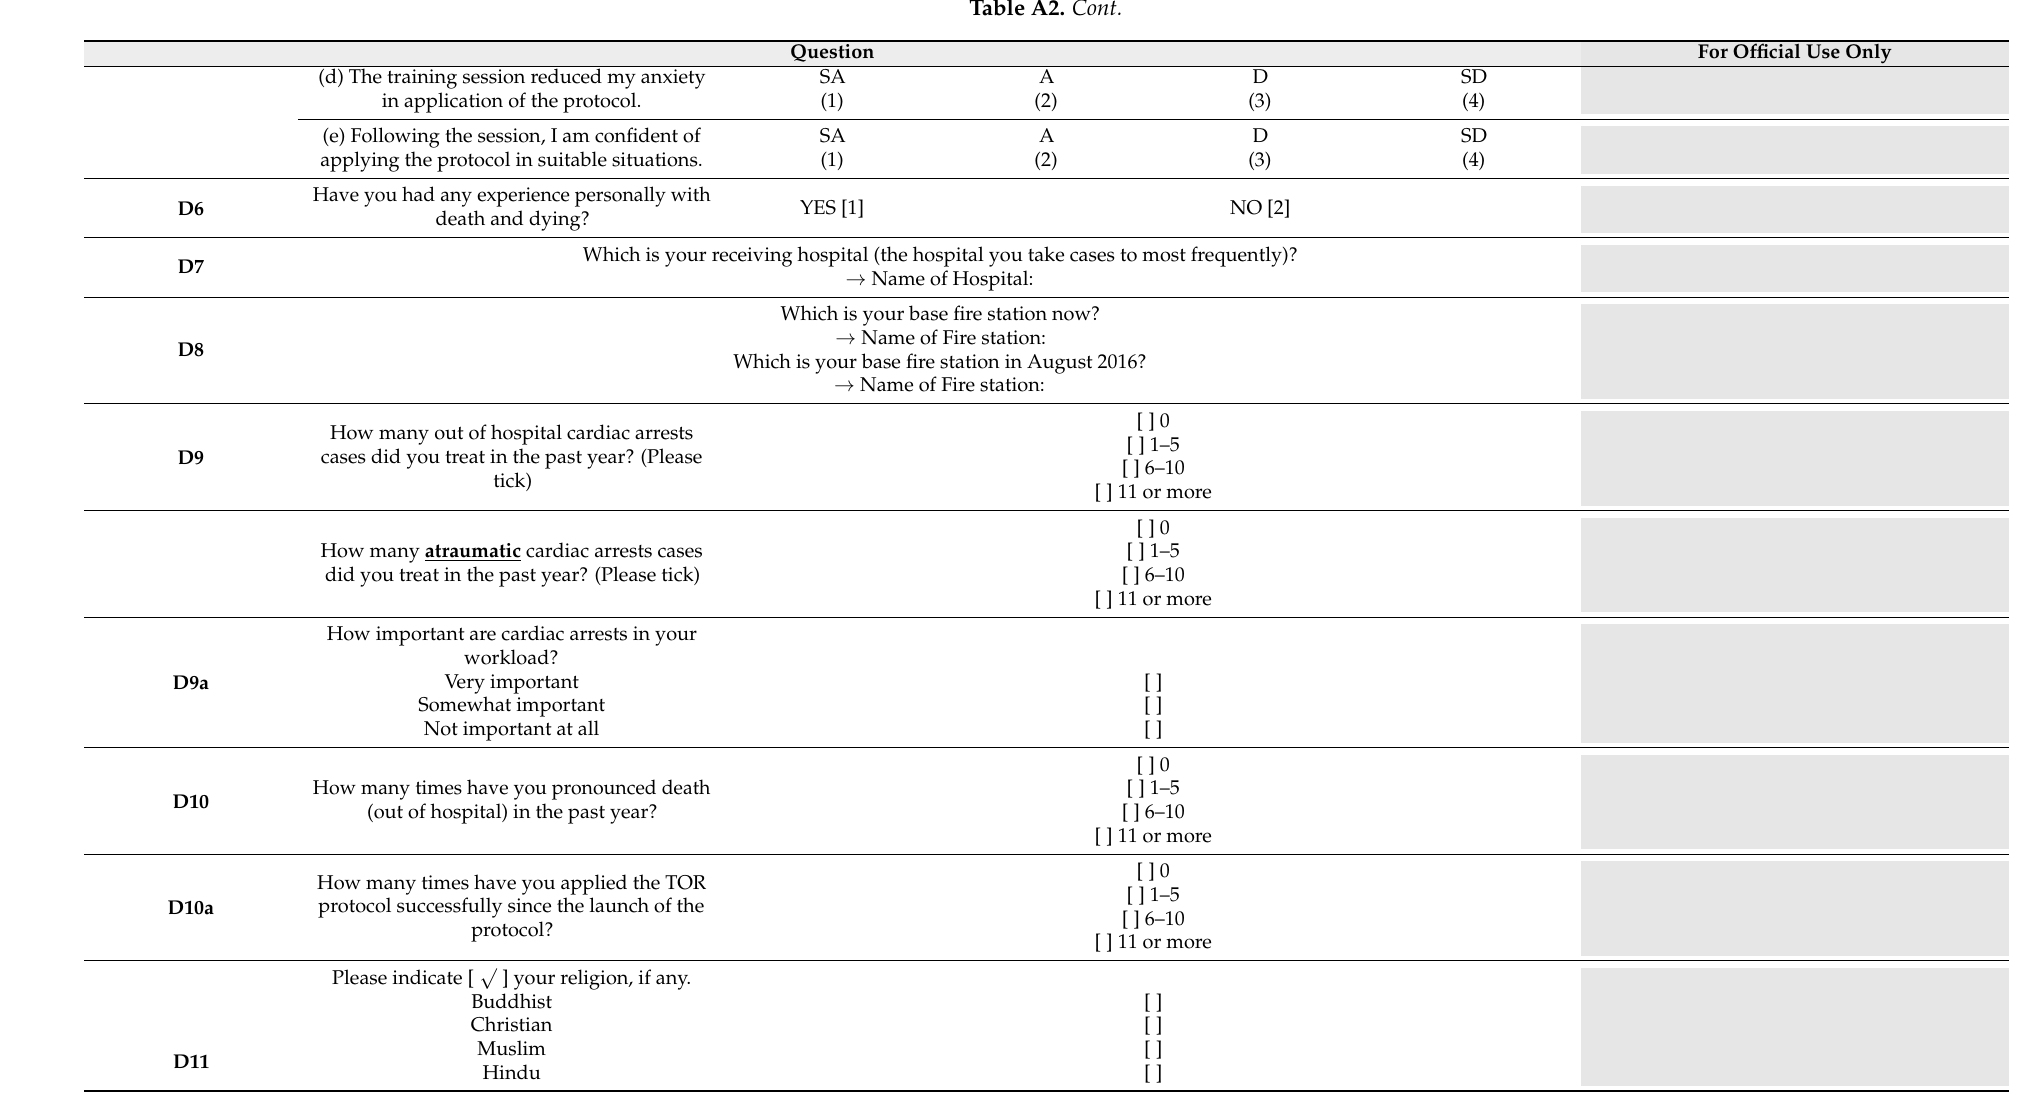
Table A2. Cont. Question For Official Use Only SA (1)